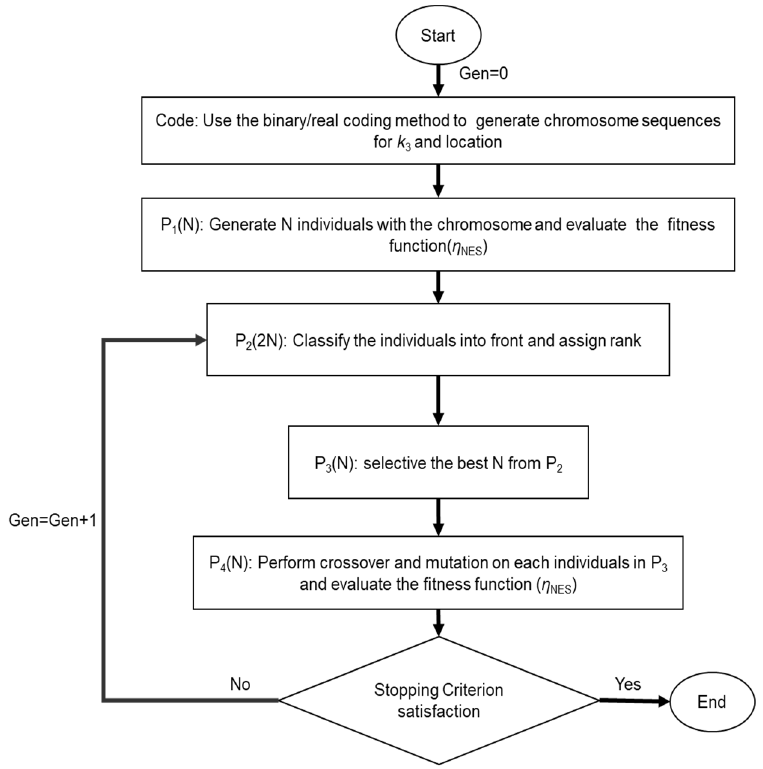
Figure 2. Flowchart of the genetic algorithm.